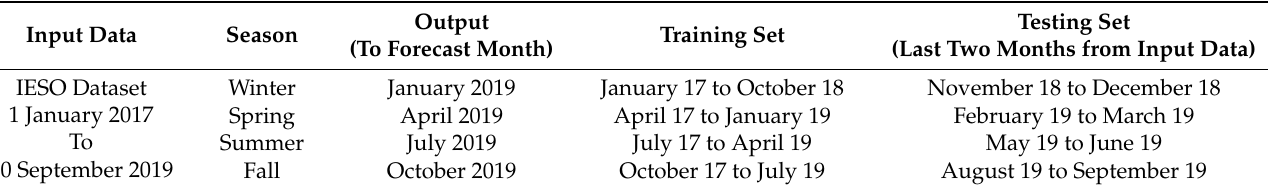
Table 1. Different forms of the input